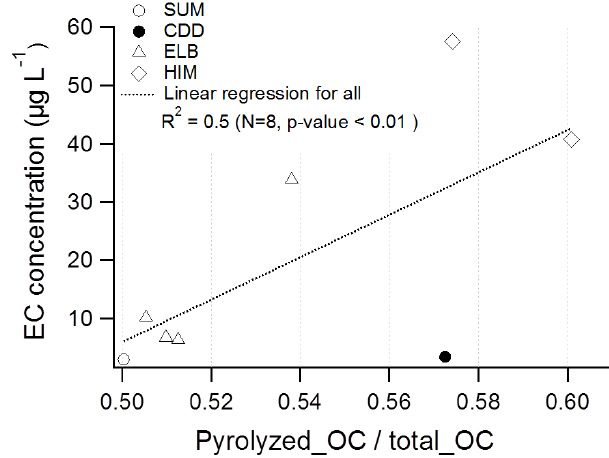
Figure 4. Comparison of pyrolyzed_OC/total_OC ratio and EC concentration for all snow and firn samples showing values of py- rolyzed_OC/total_OC ratio >